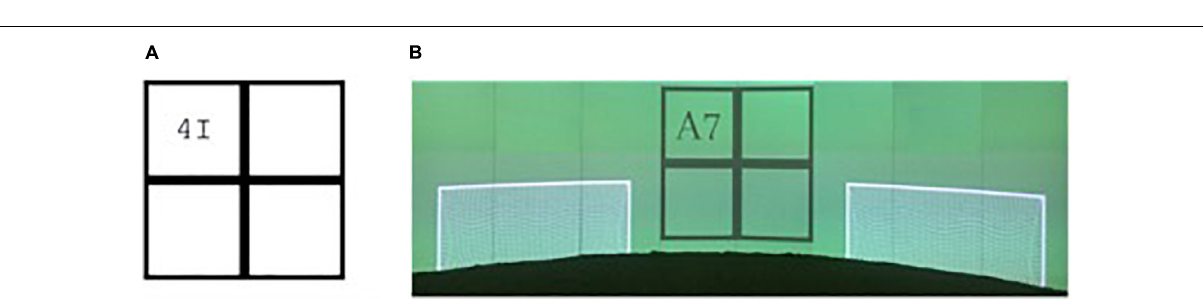
FIGURE 2 | Number-letter task in the computerized version (A) and adapted for the SoccerBot360 (B) . Images of SoccerBot reproduced with permission from Umbrella